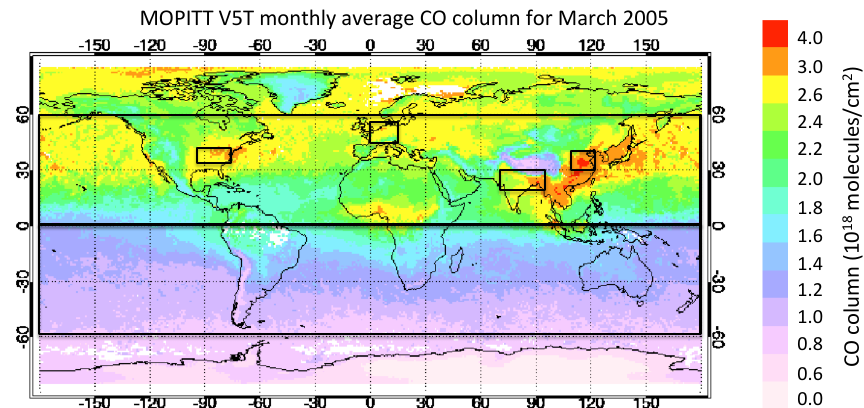
Fig. 2. Global map showing MOPITT V5T monthly average CO column for March 2005 indicating the regions used for estimating trends in this study: Northern Hemisphere [0°-­‐60°N], Southern Hemisphere [0°-­‐60°S], E. USA [35°-­‐40°N, -­‐95°